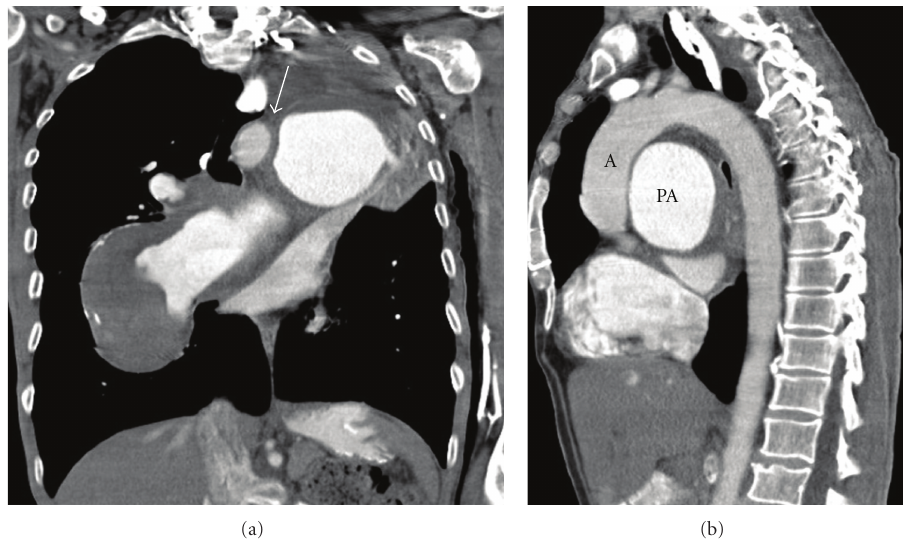
Figure 4: Coronal (a) and sagittal reformat (b) from the CT. The aortopulmonary window (arrow in (a)) is almost completely obstructed by the enlarged left pulmonary artery. (b) The sagittal reformat demonstrates the narrow space between the aorta (A) and pulmonary artery